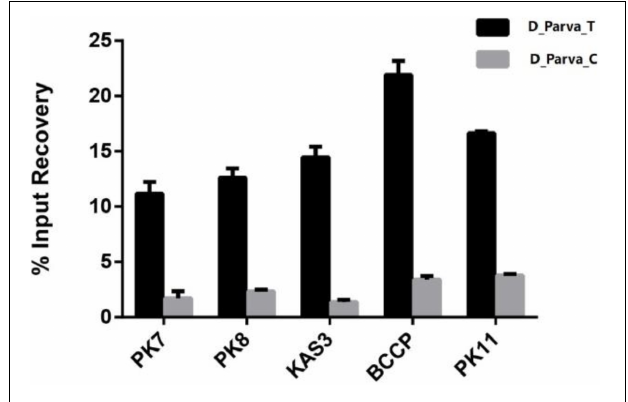
FIGURE 8 | Detection of several important genes from ChIPed DNA by real-time PCR. D_Parva_T indicated ChIPed DNA from D. parva cells under nitrogen limitation stress (0.5 mM NaNO 3 ). D-Parva_C indicated ChIPed DNA from D. parva cells under nitrogen sufficient condition (5.0 mM NaNO 3 ). Data were obtained from triplicate tests and are shown as mean ± SD. The p -values of t -test were 0.0016, 0.0003, 0.0002, 0.0001, and 3.8061E-07 when comparing five genes ( PK7 , PK8 , KAS3 , BCCP, and PK11 ) between D-Parva_C and